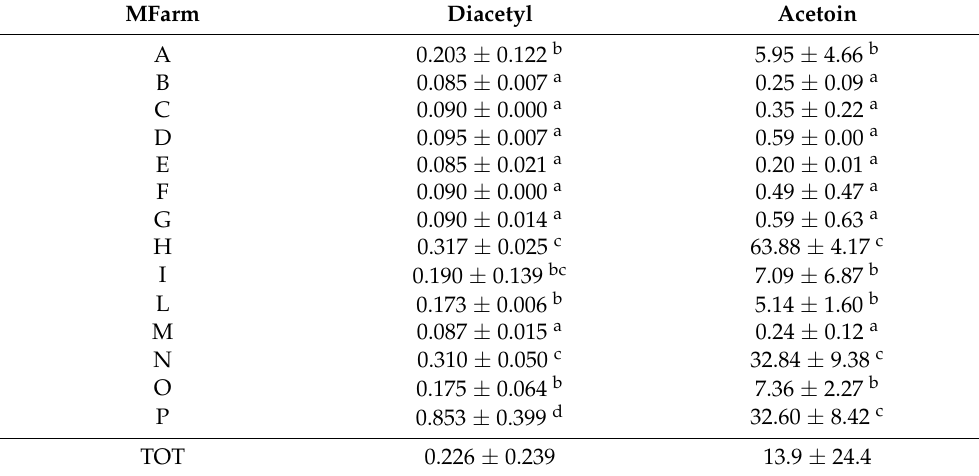
Table 2. Extraction recoveries of acetoin and diacetyl in butter samples collected from different farms at spiked levels by the GC–MS method. Data (mg/kg) are expressed as the mean ± SD (n = 3 biological replicates). For each column, the bacterial count values with a, b, c, and d superscripts are significantly different ( p < 0.05, one-way Anova with post-hoc Tukey HSD).